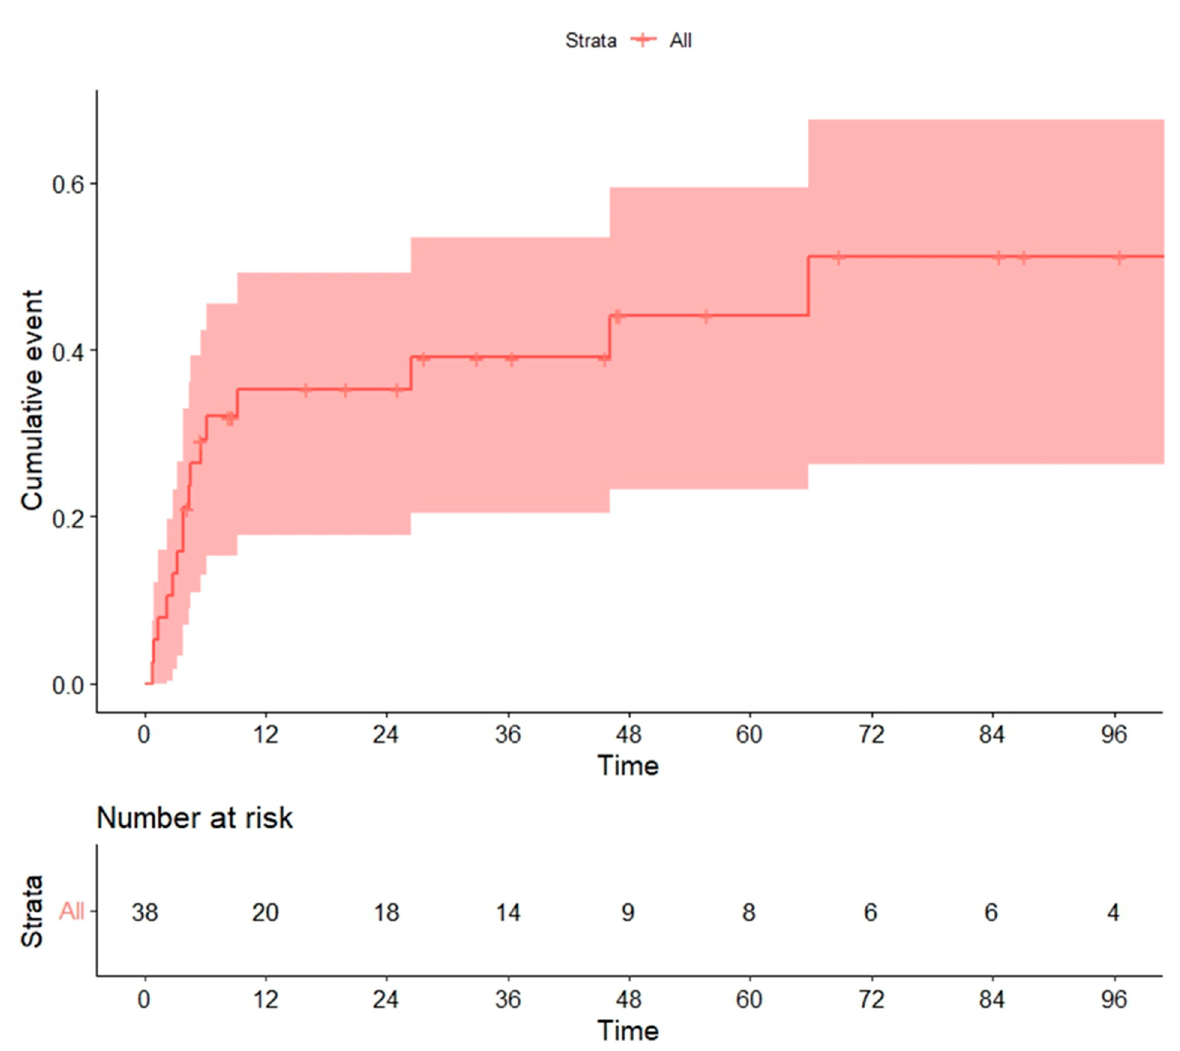
Figure 4. Non-relapse mortality (NRM) in global series.